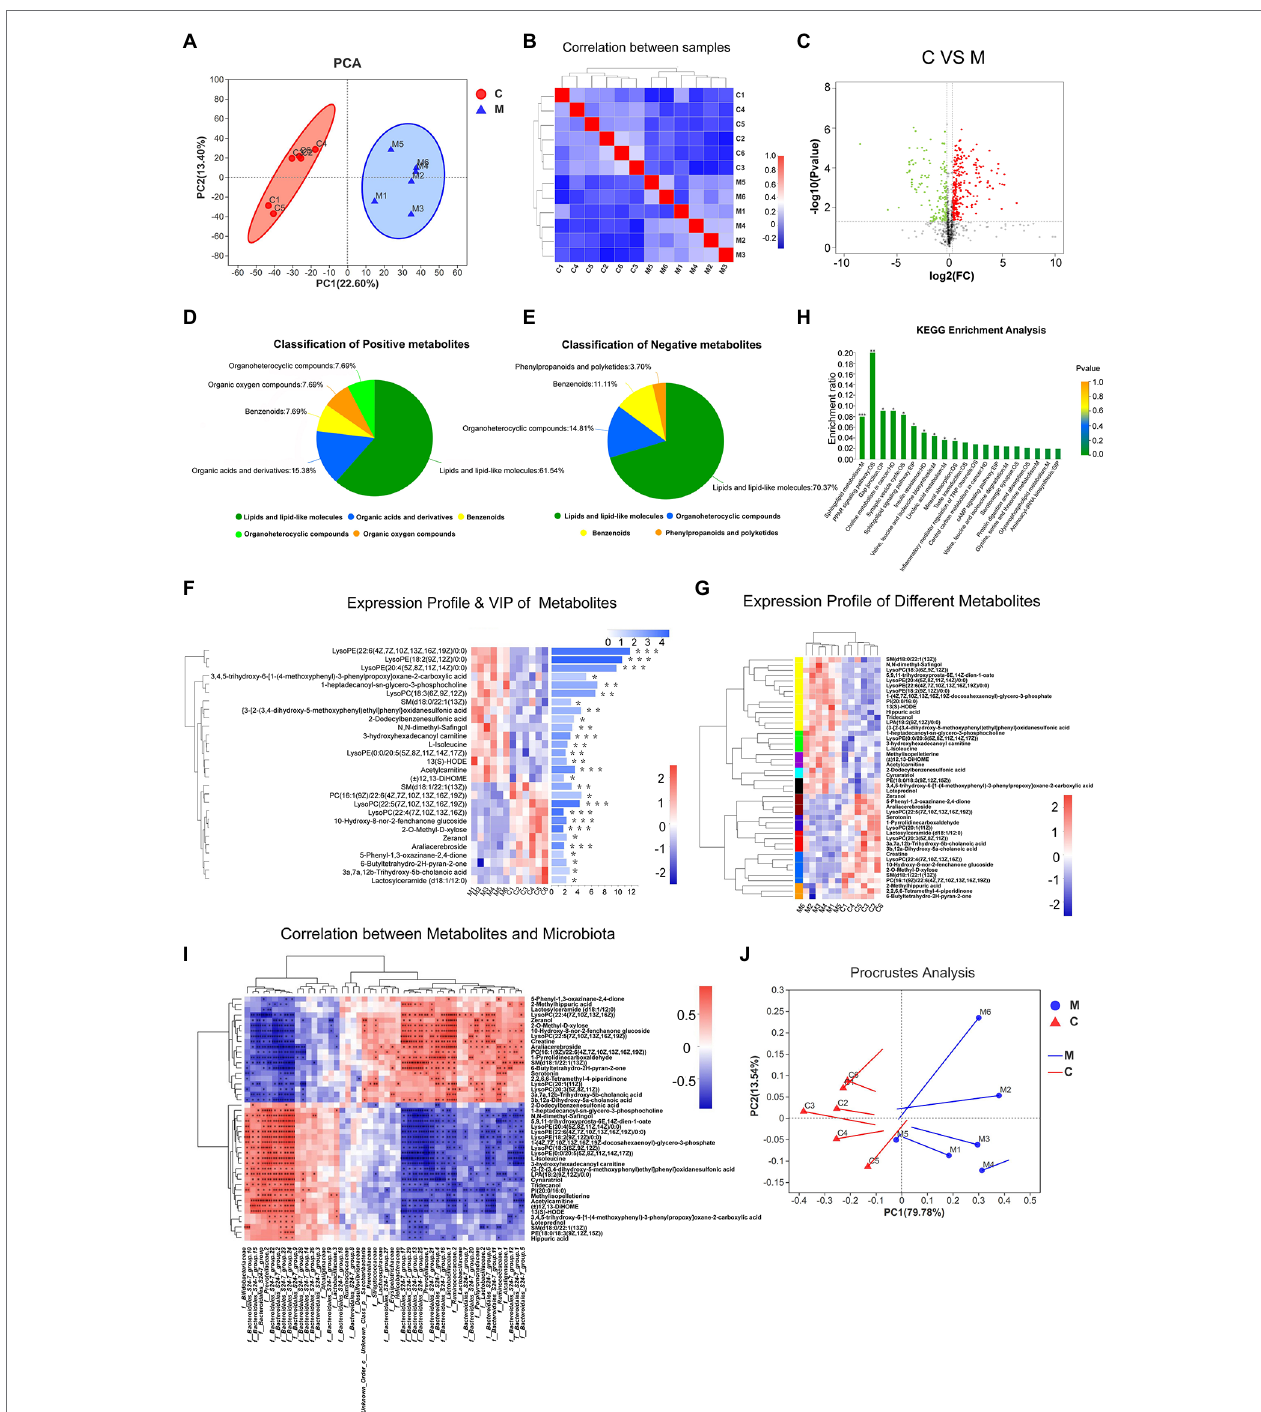
FIGURE 4 | The metabolic profiles of various samples. PCA analysis (A) and correlation analysis (B) showed the structure and similarity of metabolic composition among samples (confidence level over 95%). Identification of differential metabolites using Volcano plot analysis (C) . Up-regulated metabolites are marked by red plots, while down-regulated are presented by green plots. Based on human metabolome database (HMDB) compound, Pie plots show the classification of positive and negative metabolites (D,E) . Expression profile and VIP of differential metabolites (F,G) . Lattice color of the left heatmap represents metabolite abundance and metabolites with similar expressing patterns were clustered by tree. The corresponding VIP values were shown in the right bar chart. Metabolic KEGG analysis (H) . Acronyms denote the classification of metabolic pathways. M, metabolism; OS, organismal systems; EIP, environmental information processing; CP, cellular processes; HD, human diseases; and GIP, genetic information processing. According to the relative abundance, correlation between differential microbiota and metabolites was performed by heatmap using Spearman correlation analysis (I) . Similarly, Procrustes analysis showed variations between microbiota and metabolites. Solid dots of line segment were on behalf of microbiota data and the other end denoted metabolic data ( J ; 0.01 < * p < 0.05; 0.001 < ** p ≤ 0.01; and *** p ≤